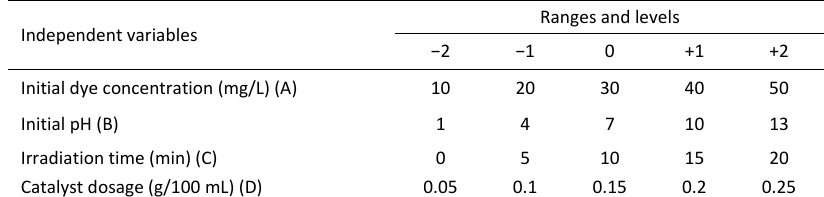
Table 2: Experimental range and levels of independent variables for UV–Vis/ BiVO Independent variables